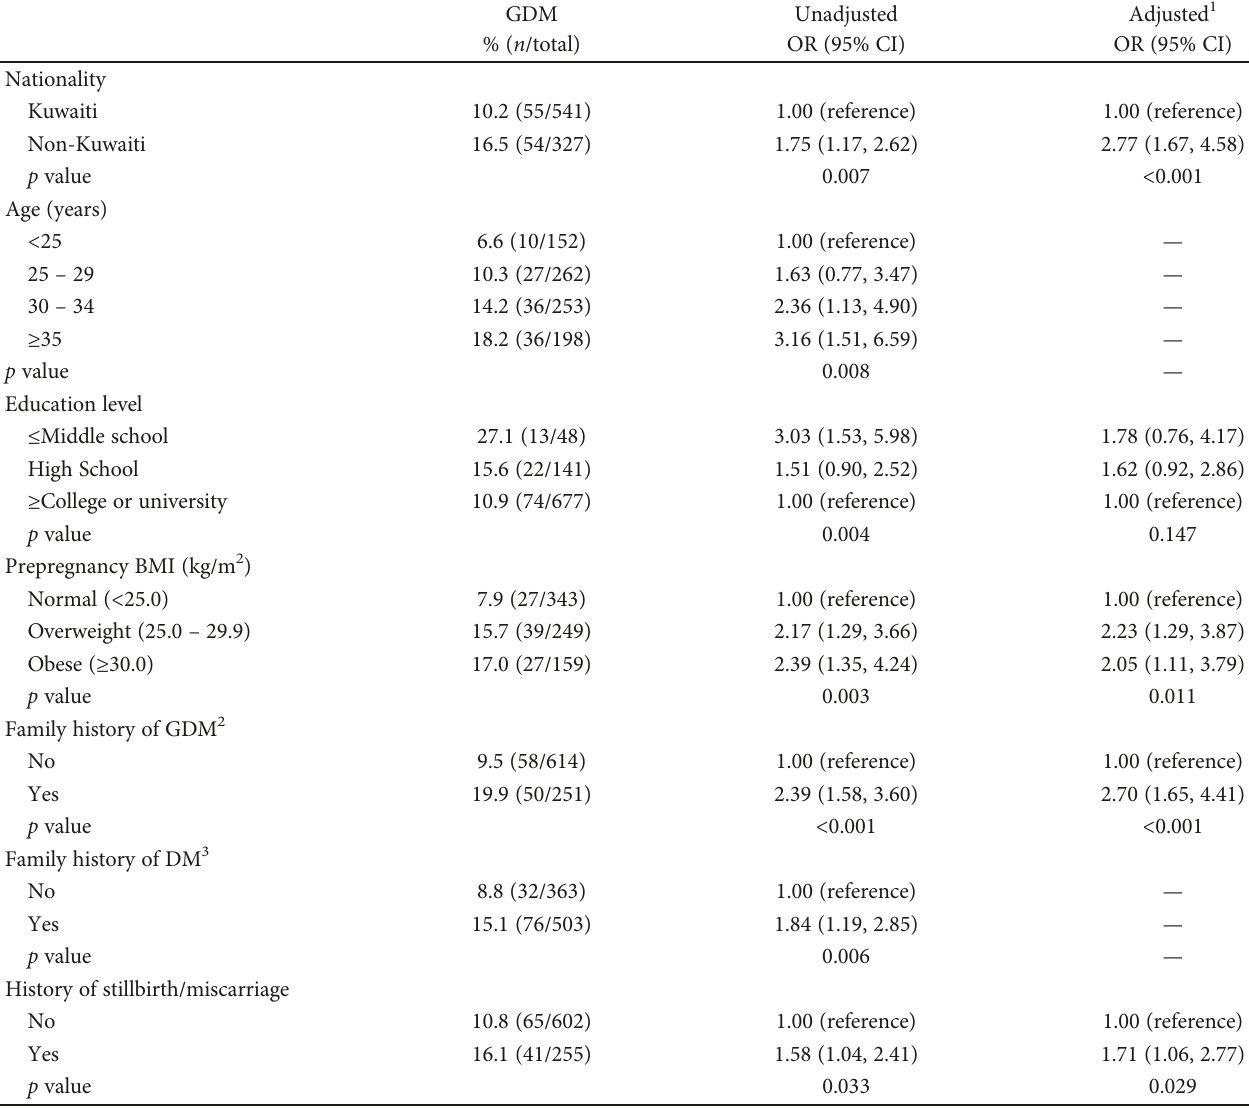
Table 2: Associations between maternal characteristics and gestational diabetes mellitus